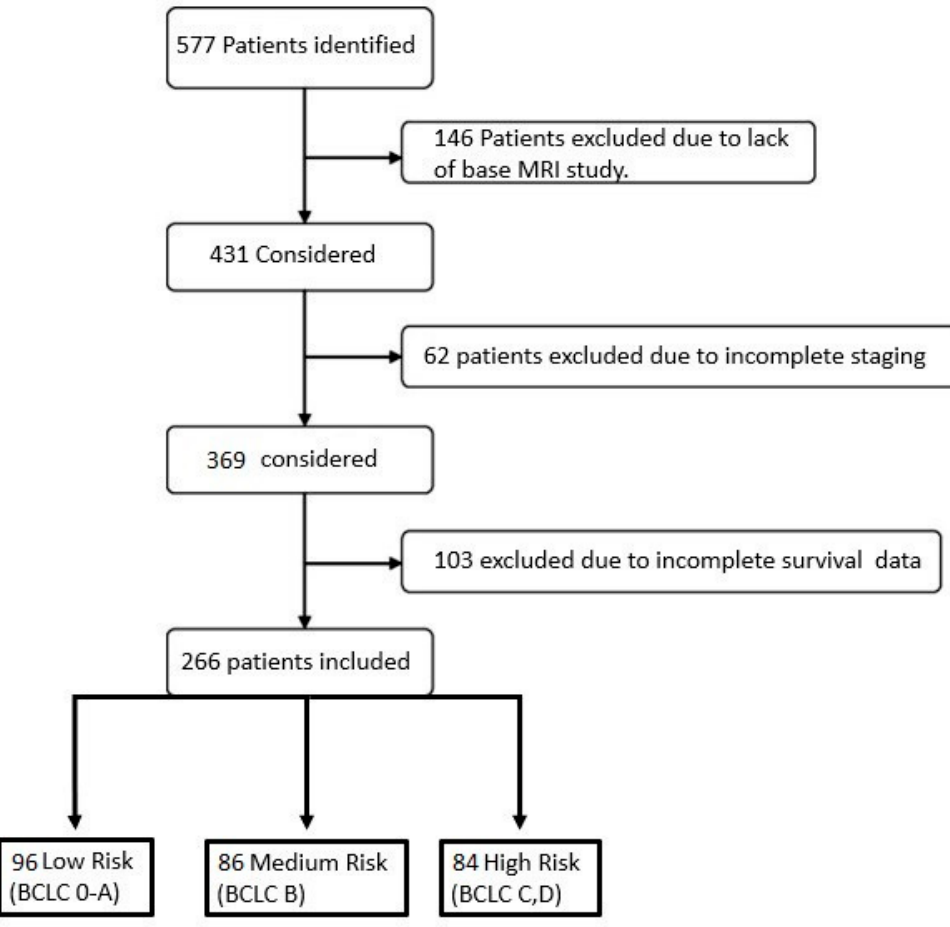
Figure 1. Flow chart of the patients included in the present study. Figure 2 also demonstrates the effect of adding trees on the error rate of the classifica- tion. Figure 3 presents the set of variables, their respective depth, and their importance. Table 1. Demographic, biochemical lab results, clinical staging, and semantic imaging findings of patients included in the present study. and adcglobalskewness, showed great performance (see Supplementary Figure S1). A